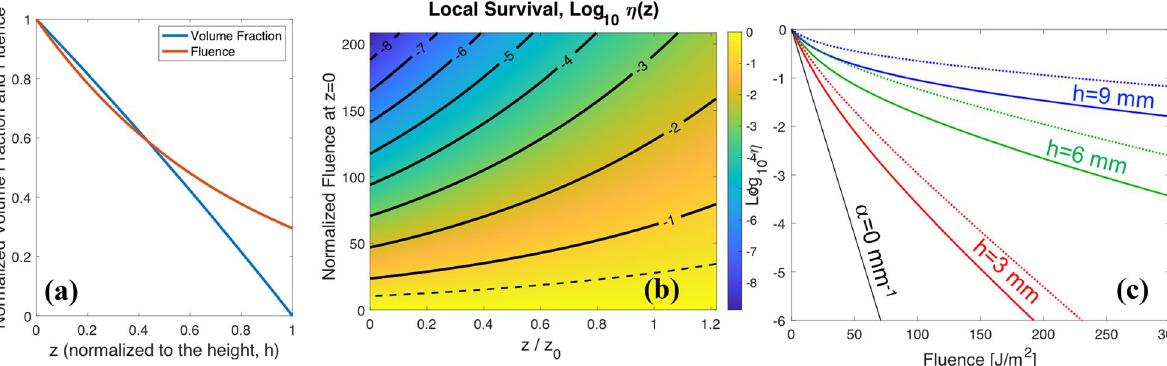
Figure 3. ( a ) Dependence of the volume fraction (in blue), and fluence (in red) when moving from the air/ liquid interface, z = 0 , towards the bottom of the drop, z = h cap . In this plot we assumed a value of h cap = 2.6 mm, a volume V = 300 µ L, and an absorption coefficient α = 0.47 mm − 1 . ( b ) Local survival rate, η , in log 10 representation for each layer of the drop as a function of the depth within the drop and the incident fluence, F . The location within the drop, z , is normalized to z 0 = 1 /α where the fluence drops to 1/ e of the incident fluence. The fluence value is normalized to the characteristic inactivation fluence, F i . The dashed line corresponds to a local survival ratio of 0.37 (related with the characteristics fluence F i trough Eq. (1)), and the solid lines with labels -1, -2, -3, etc. represent local survival ratios of 0.1, 0.01, 0.001, etc., respectively. ( c ) Estimated inactivation ratio for a characteristic fluence F i = 5 J/m 2 (susceptibility k = 0.2 m 2 /J), and absorption coefficient α = 0.5 mm − 1 in spherical cap geometry (solid line) and cylindrical geometry (dotted line). The calculation has been done for three heights h cyl = h cap = h = 3, 6 and 9 mm (red, green, and blue plots, respectively). The black thin solid line is for a non-absorbing sample ( α = 0